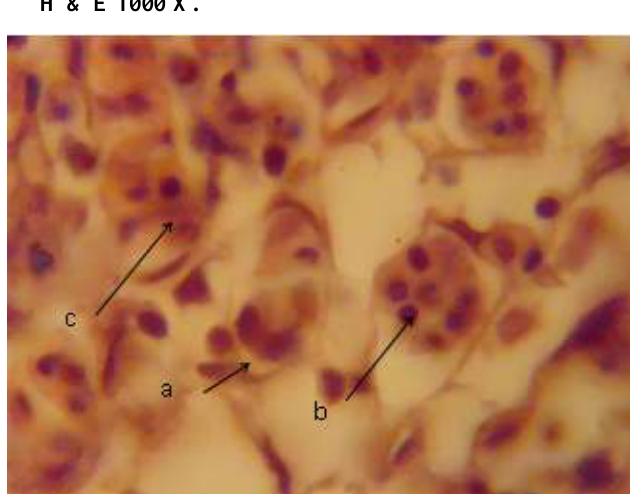
Figure 9: Histological section of gill Cyprinus carpio infected with Branchiomyces spp. , revealing (a) Multinucleate sporangium-like body; (b) divided sporonts ; (c) uninuclear progemy of plasmodium. ). H & E 1000 X.